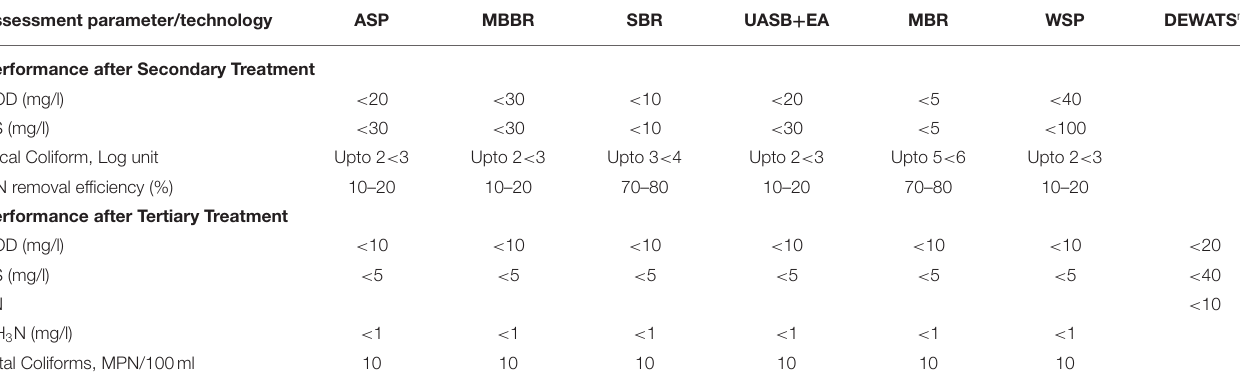
TABLE 7 | Technology performance (CPCB, 2013; adapted with data based on DEWATS by Singh et al., 2019). Assessment